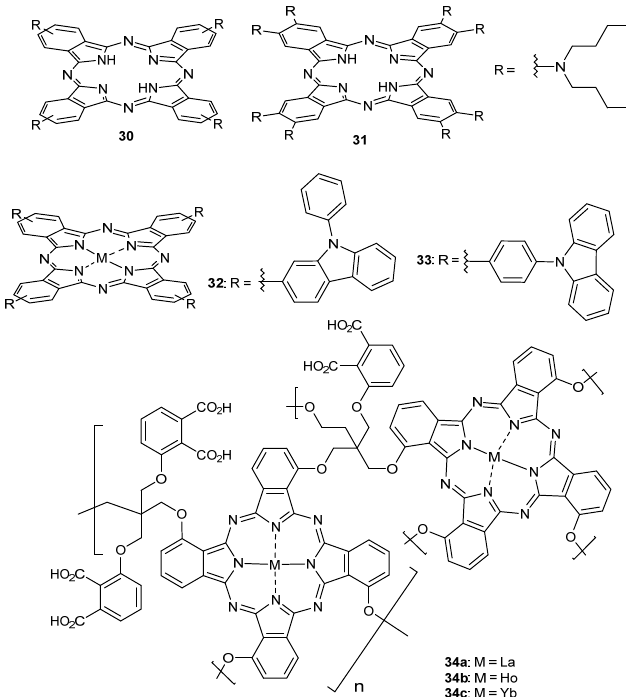
Figure 12. Phthalocyanines for nonlinear optics applications. The electronic absorption spectra of Pcs 30 and 31 were recorded in CHCl 3 , where 30 shows a characteristic non-aggregated absorption spectrum of the metal-free phthalocya- nines with a relatively broadened Soret absorption band appearing at 340 nm and a broad Q band at 765 nm. Of note, theoretical calculations revealed that, unlike typical metal-free Pcs [142,143], the Q band for 30 did not get split because of the more effective p- π conju- gation between the peripheral nitrogen atoms and the central phthalocyanine chromo- phore, therefore extending the effective conjugation system for Pc 30 (Figure 13).